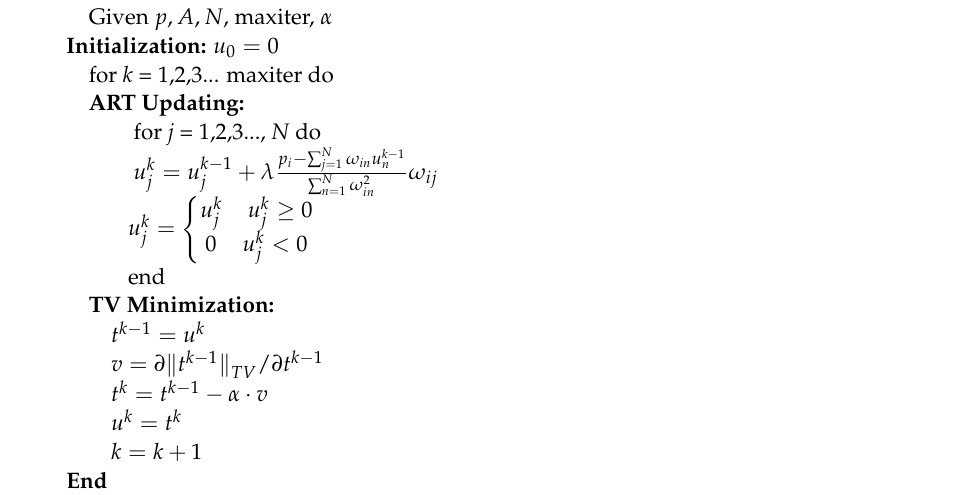
( b ) Figure 6. ( a ) Laser reflection projection data after registration; ( b ) converted projection data in com- plete angle. For the projection data in the near-field experiment, the proposed TV sparse imaging reconstruction method in Section 3.2 is performed compared with FBP [10 – 13], ART [14], and sparse ART with a complete view of projections and uniformly sampled projections in 5°, 10°, and 20° viewing intervals. The results are shown in Figure 7. In Figure 7a, the iRadon [3,9] results are illustrated just to show the target contour according to the defini- tion in Equation (1), as mentioned in Section 3.1. In Figure 7(a4), for sparse ART with OMP algorithm mentioned in Section 3.2.2, because of using discrete Fourier transform as a sparse basis, it cannot make good use of the gradient sparse features of laser image, lead- ing to obvious deviation between the reconstructed contour and the original target. Then, for Figure 7(a2,a3,a5), the target contour is very clear after imaging with all three ap- proaches. In Figure 7(a5), the resolution of the reconstructed image is significantly im- proved by using the proposed algorithm compared to Figure 7(a2). Comparing Figure 7(a5) with Figure 7(a3), there are artifacts in the image reconstructed by the traditional ART, which are mostly eliminated in the result of the proposed method. Therefore, in the case of the complete angle, the proposed algorithm greatly improves the resolution of the reconstructed image and reduces the image artifacts.